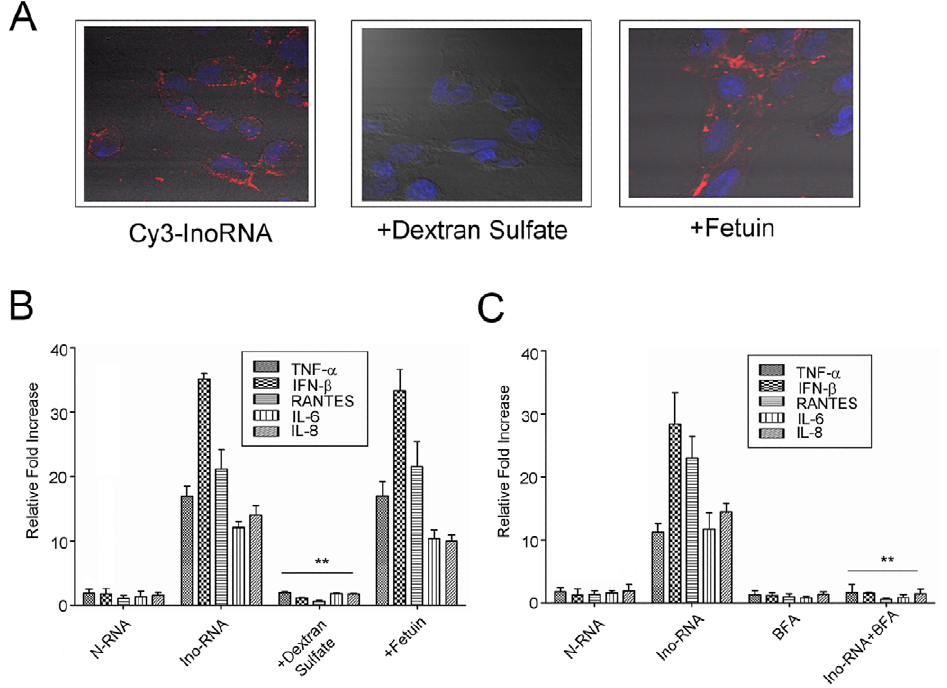
Figure 6. Ino-RNA internalization is through SR-A-mediated endocytosis. Panel A , Involvement of scavenger receptors in uptake of 10% Ino-RNA was determined by using dextran sulfate or fetuin. PHBE cells were treated with 10 m g/ml Cy3-labeled Ino-RNA for 5 min, or were treated with 10 m g/ml dextran sulfate or fetuin immediately before addition of Ino-RNA. After 5 min, cells were washed, mounted, and were used in confocal microscopy. Panel B , PHBE cells were treated with dextran sulfate or fetuin immediately before treatment with 10% Ino-RNA. After 2 hr total RNA was extracted and used in real-time RT-PCR. Panel C , PHBE cells were treated with endosomal acidification inhibitor BFA (100 nM) for 45 min and then 10% Ino-RNA for 2 hr. The total RNA was extracted and used in real-time RT-PCR. Error bars indicate standard error of the mean (n=3, 6 SEM, **p , 0.01).